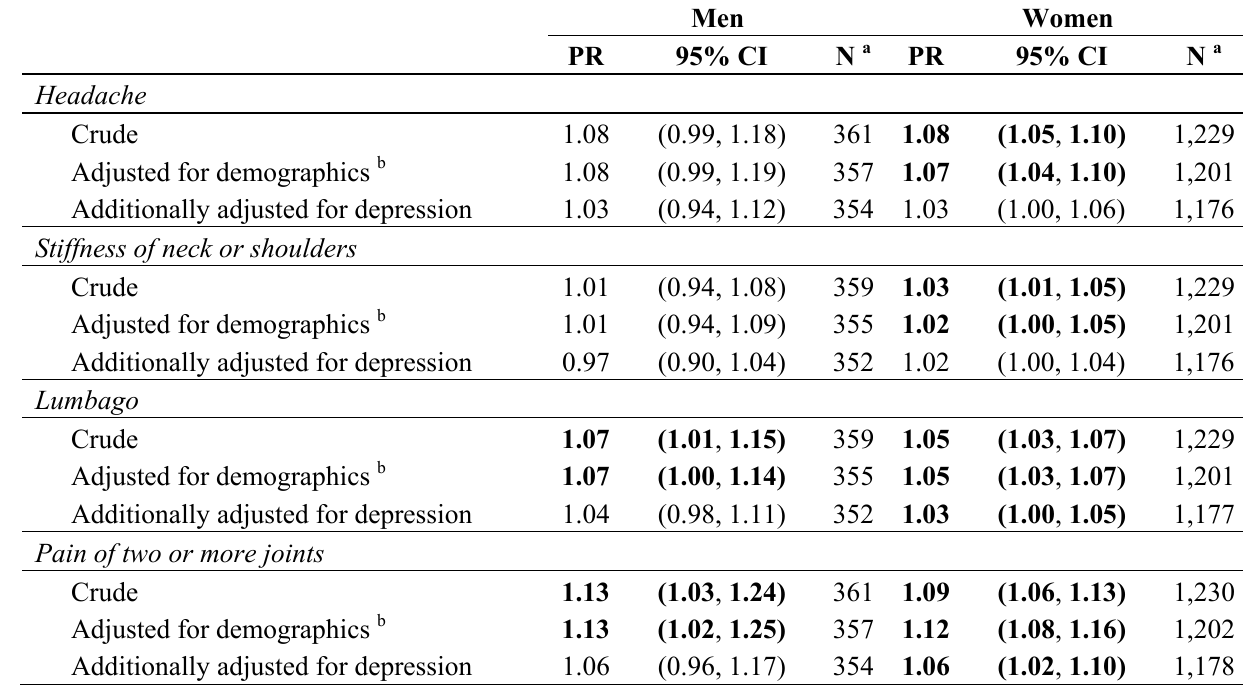
Table 4. Changes in the prevalence ratio associated with a 1-point increase in the sexual harassment score. Men